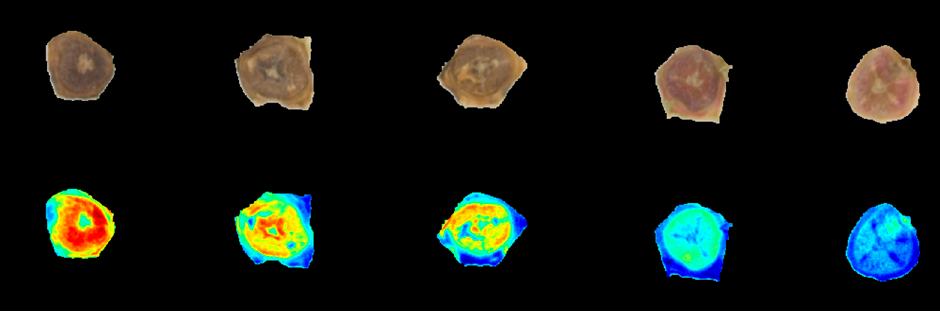
Figure 2. Multispectral images (top row) and corresponding transformed image (bottom row) of seed in maturity class 5 to 1 (left to right), where class 5 is the most mature seed.